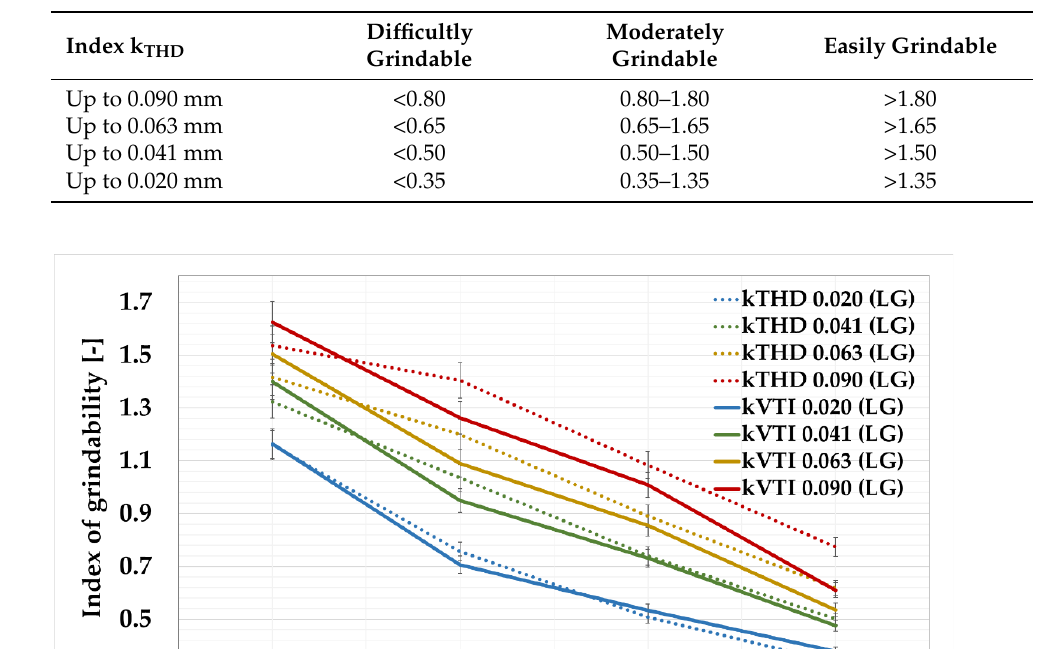
Table 16. New classification of material based on grindability index according to the new THD method.